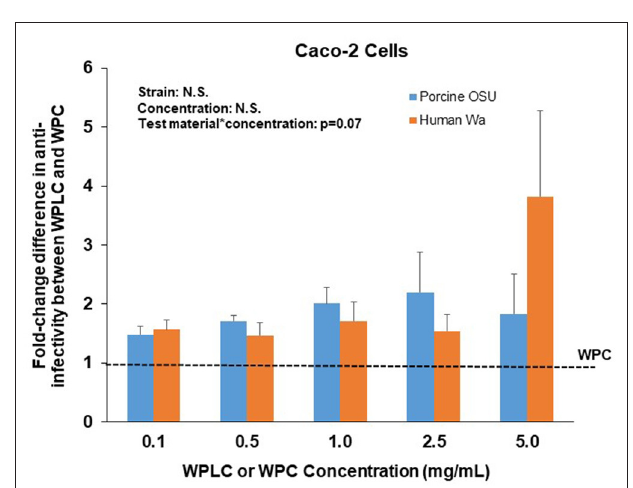
FIGURE 4 | Fold-change difference in anti-RV activity of WPLC and WPC in Caco-2 cells infected with porcine RV OSU or human RV Wa. Data are represented as means ± SEM of three separate experiments. Fold-change represents the ratio between WPC and WPLC efficacy to reduce % infectivity at each concentration tested. At similar concentrations, WPLC efficacy over WPC to reduce infectivity of both strains OSU and Wa was equal in Caco-2 cells. RV, rotavirus; WPC, whey protein concentrate; WPLC, whey protein lipid